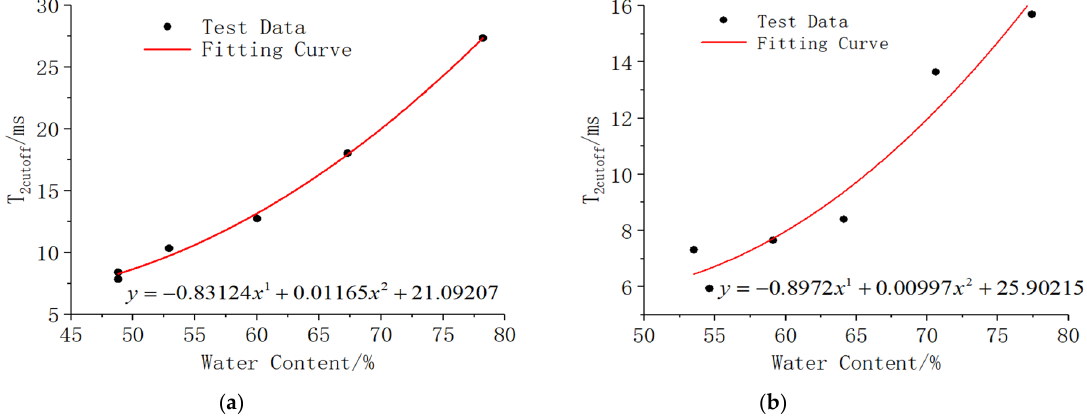
Figure 10. The relationship between the T 2 cuto ff and the water retention of the samples. ( a ) concentration of 71%; ( b ) concentration of